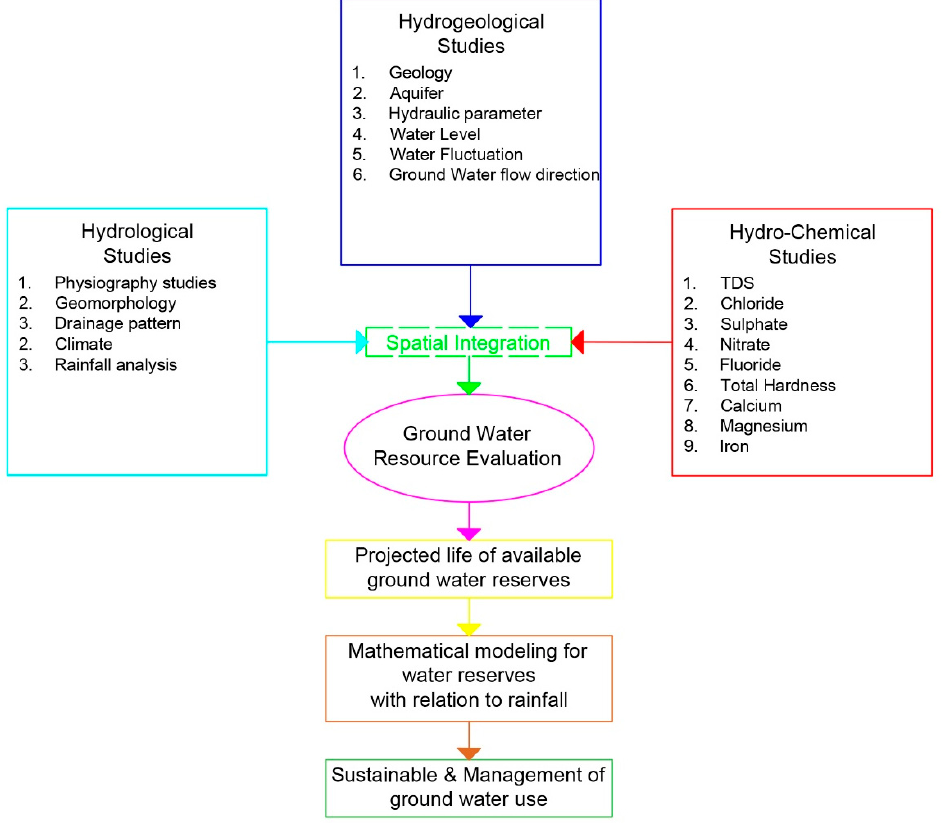
Figure 2. The overall methodology employed in the present study.